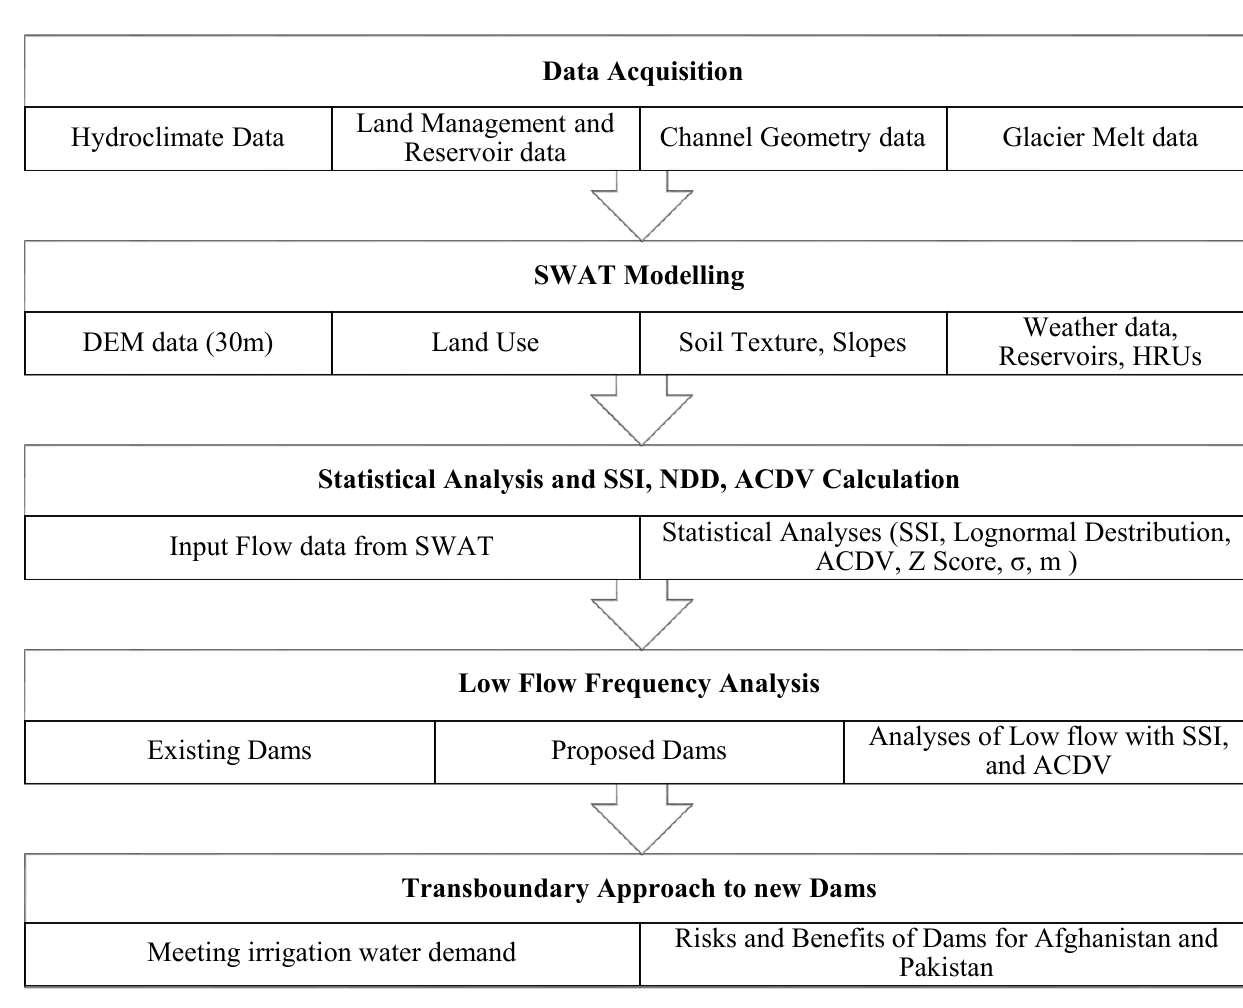
Figure 2. Flowchart that visualizes the study of the KRB.